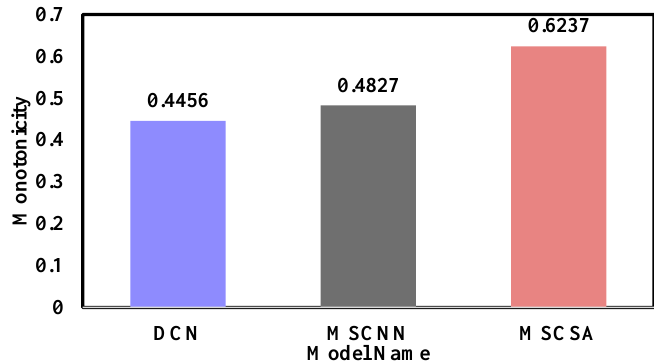
Figure 7. Monotonicity of the quantified damage using three models.